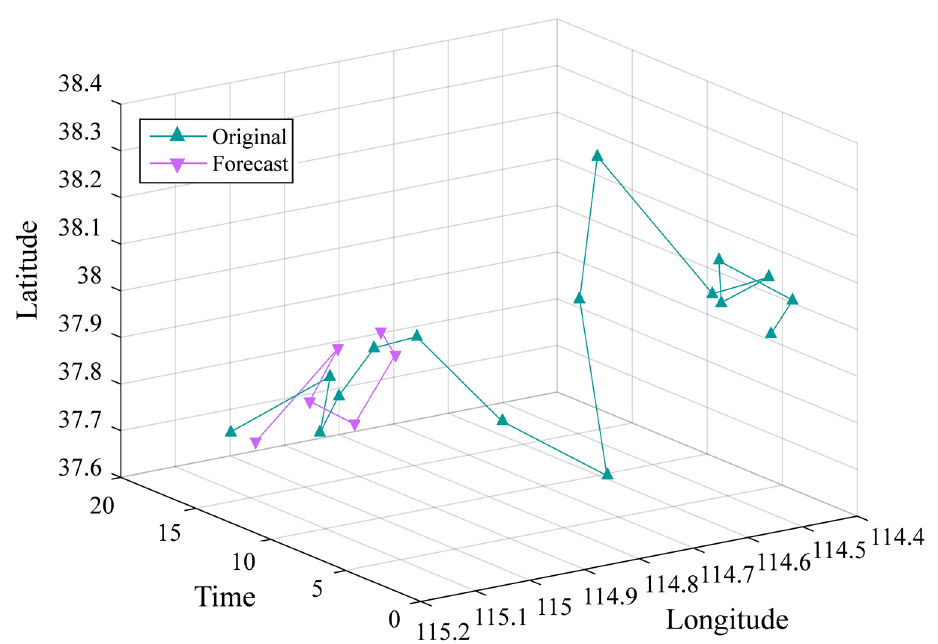
Figure 13. Comparison diagram of patient predicted trajectory.